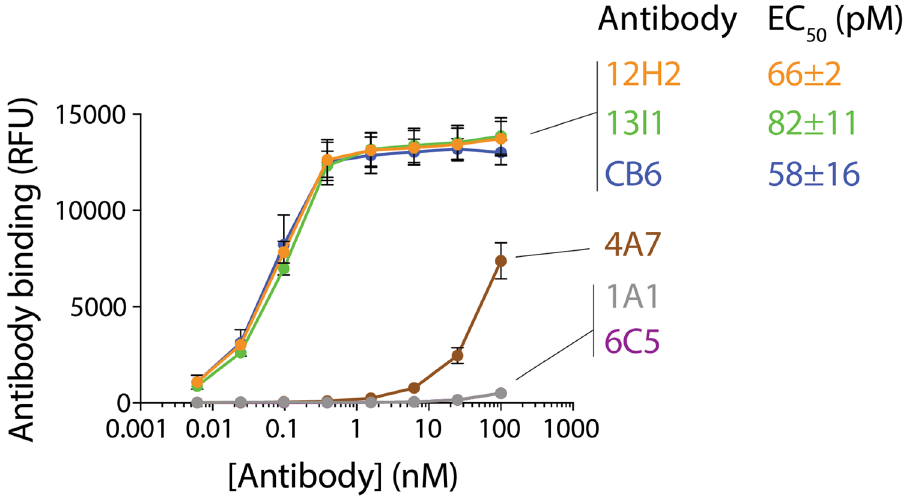
Figure 4. Isolated antibodies possess high affinity for the SARS-CoV-2 receptor-binding domain. Flow cytometry analysis of binding of antibodies to biotinylated SARS-CoV-2 RBD immobilized on magnetic beads was assessed via flow cytometry. Half-maximal effective concentrations (EC 50 ) are presented for the high affinity antibodies (12H2, 13I1) and a positive control antibody (CB6). The results are averages of three independent experiments and the error bars are standard deviations.